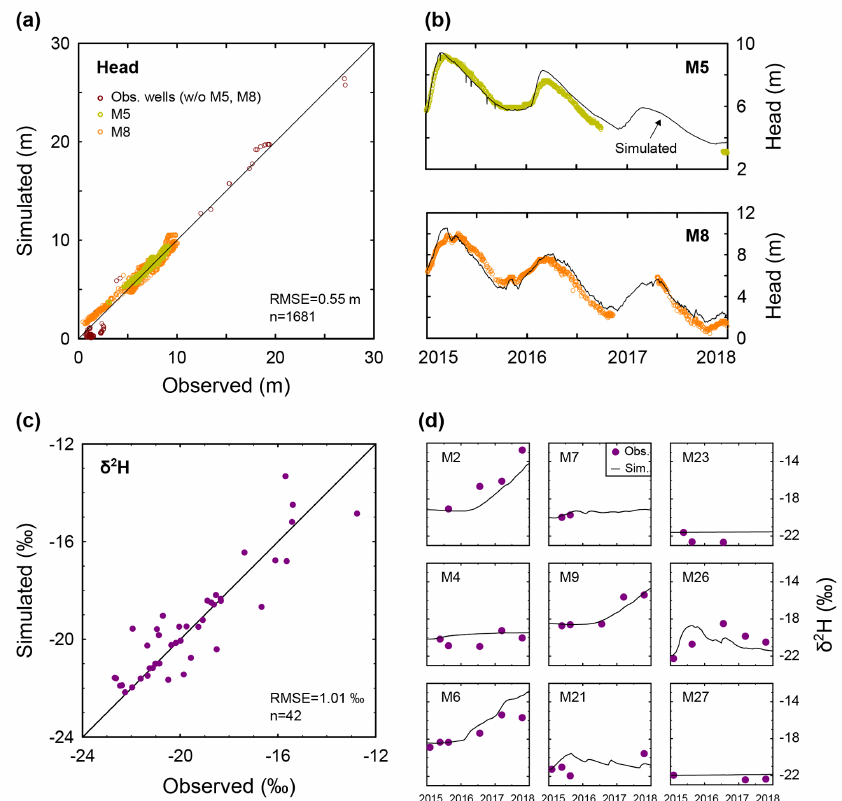
Figure 4. Model calibration. (a) Comparison of the simulated and observed hydraulic head. (b) Temporal variations of the simulated and observed hydraulic head in wells M5 and M8. (c) Comparison of the simulated and observed δ 2 H. (d) Temporal variations of the simulated and observed δ 2 H in nine selected